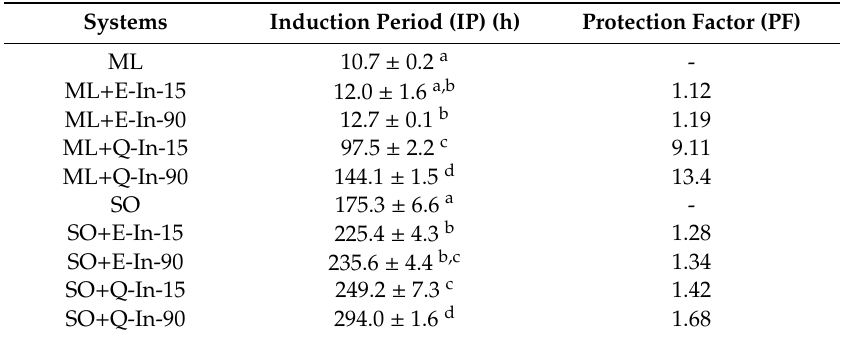
Table 2. Induction period (IP) and protection factor (PF) for methyl linoleate (ML) and sunflower oil (SO) with and without amorphous or semi-crystalline flavonoid microparticles (200 mg / kg ML or